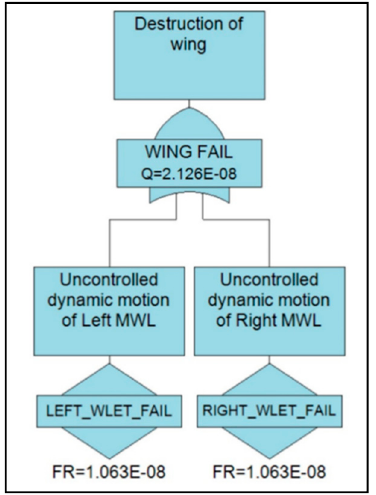
Figure 9. Destruction of wing—fault tree analysis.